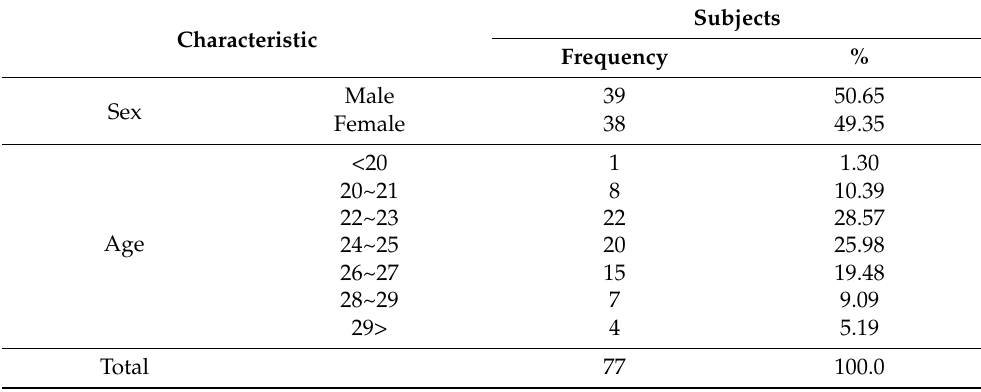
Table 6. The demographic information of users.